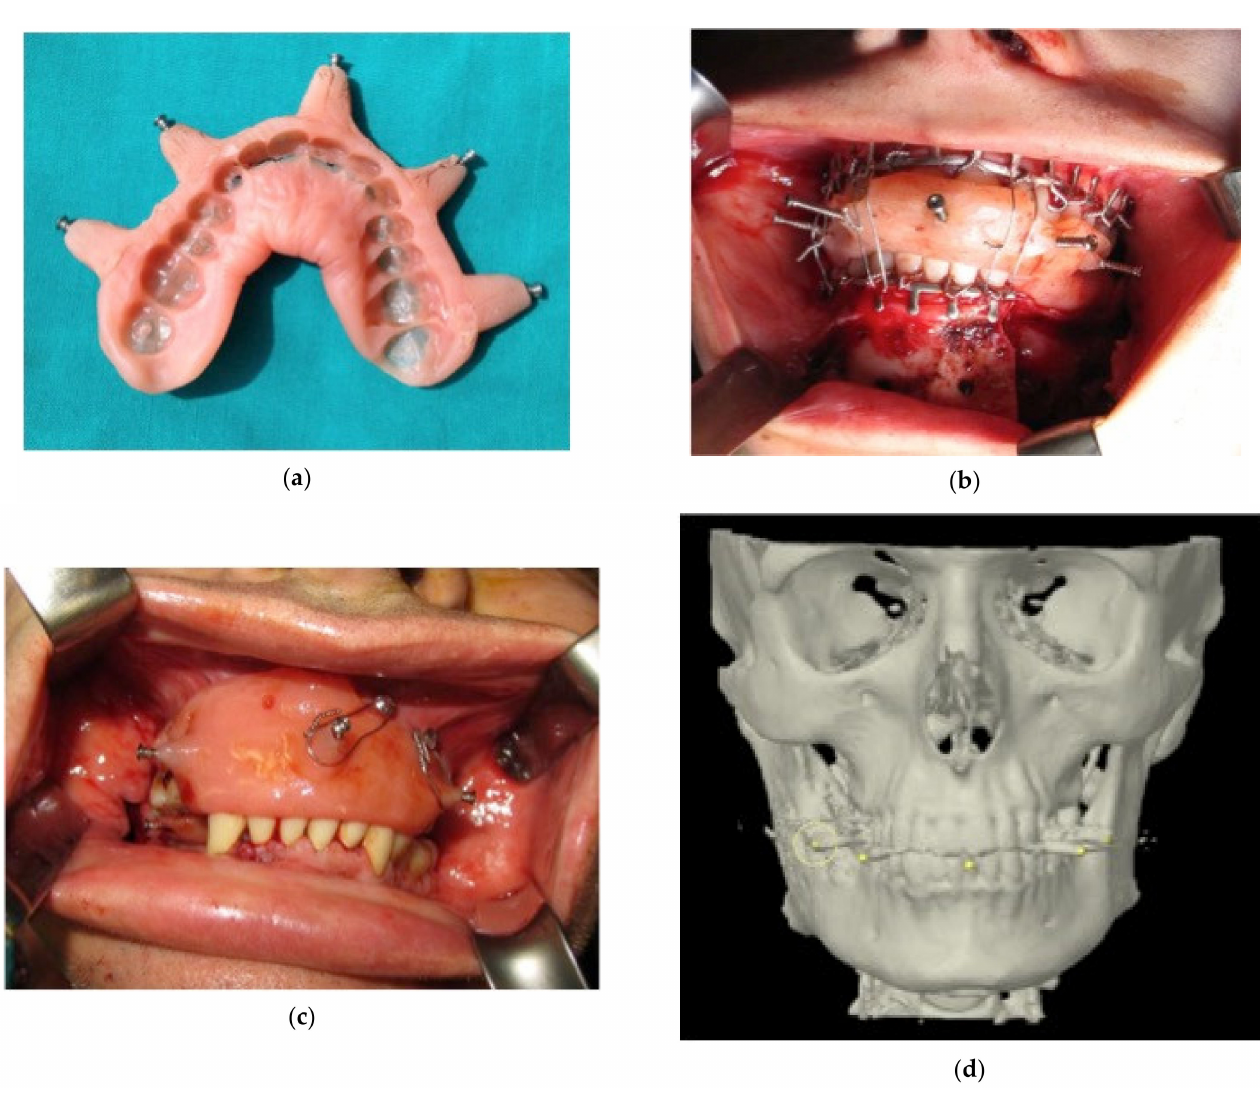
Figure 1. ( a – d ): The dental splint is manufactured in order to include the fiducial markerpoints and to maintain a rigid intermaxillary